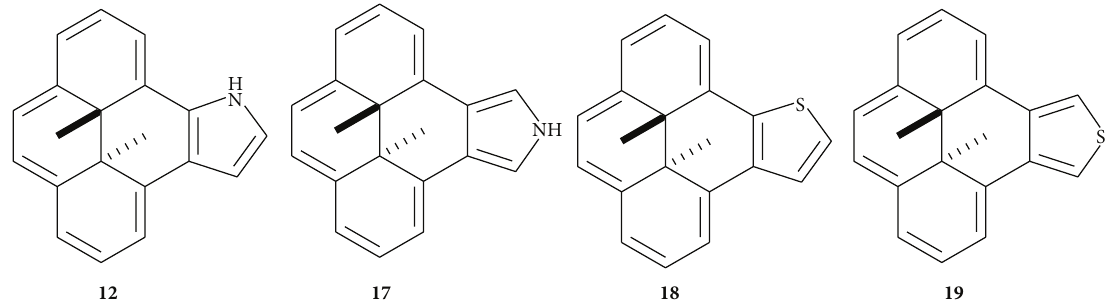
Figure 4: Pyrrole and thiophene fused